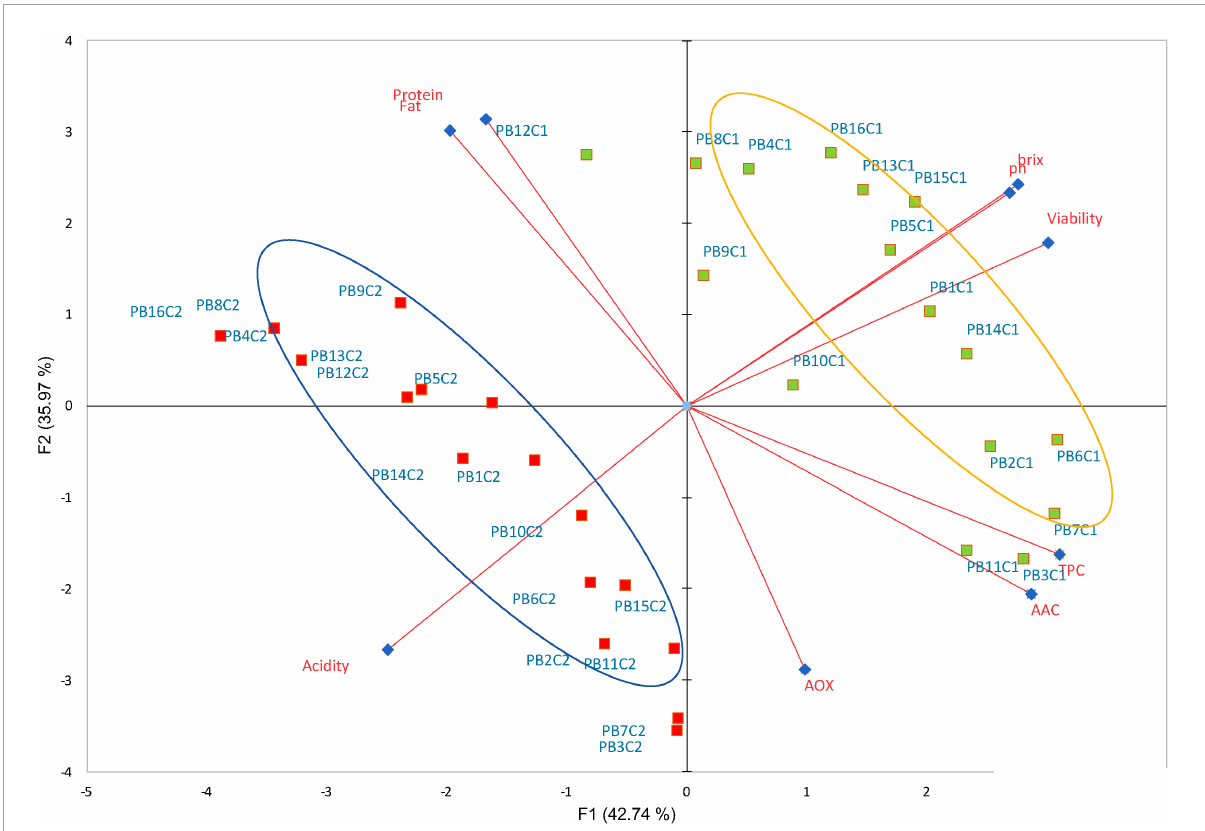
FIGURE7 Biplot PCA analysis of the nine variables (pH, titratable acidity, Brix, TPC, AOX, AAC, protein, and fat) of PBs obtained with the four probiotic strains. The green and red rectangles represent the PBs at day 1 and 21, respectively. Legend: PB1–PB4: (CSMF1–CSMF4) + UTNGt2; PB5–PB8: (CSMF1–CSMF4) + UTNGt5; PB9–PB12: (CSMF1–CSMF4) + L.Lac; PB13–PB16: (CSMF1–CSMF4) + L.r. CSMF1: semi-skimmed milk + 1% cocoa + 2% glucose; CSMF2: semi-skimmed milk + 2% cocoa + 2% glucose; CSMF3: semi-skimmed milk + 3% cocoa + 2% glucose; CSMF4: semi-skimmed milk + 2% glucose; C1–C2: values registered at 1 and 21 days for each variable. TPC, total polyphenol content; AOX, antioxidant activity; AAC, acid ascorbic content.